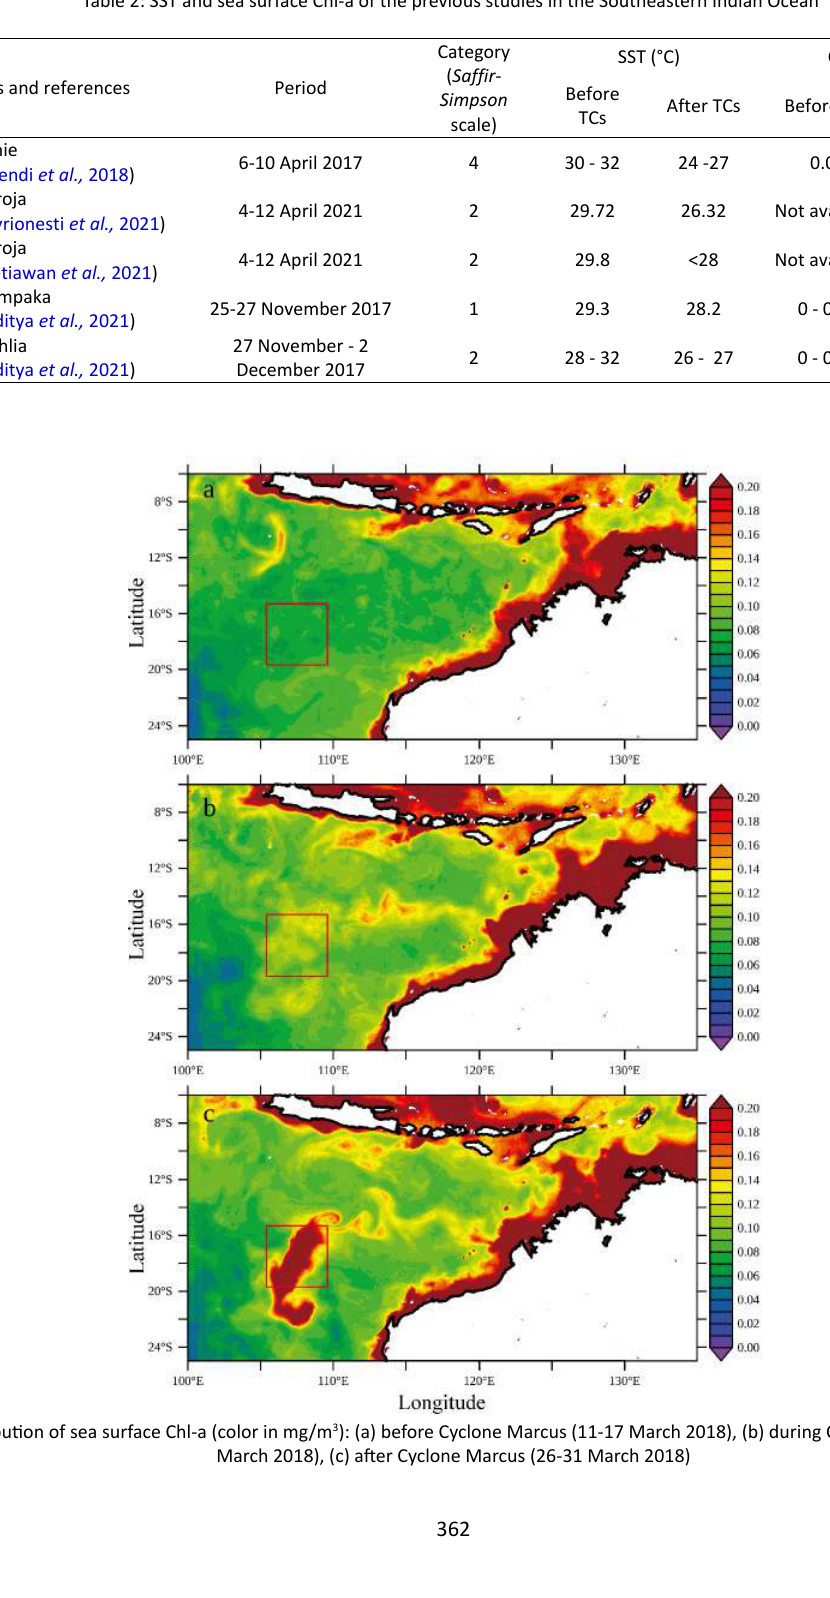
Table 2: SST and sea surface Chl‐a of the previous studies in the Southeastern Indian Ocean